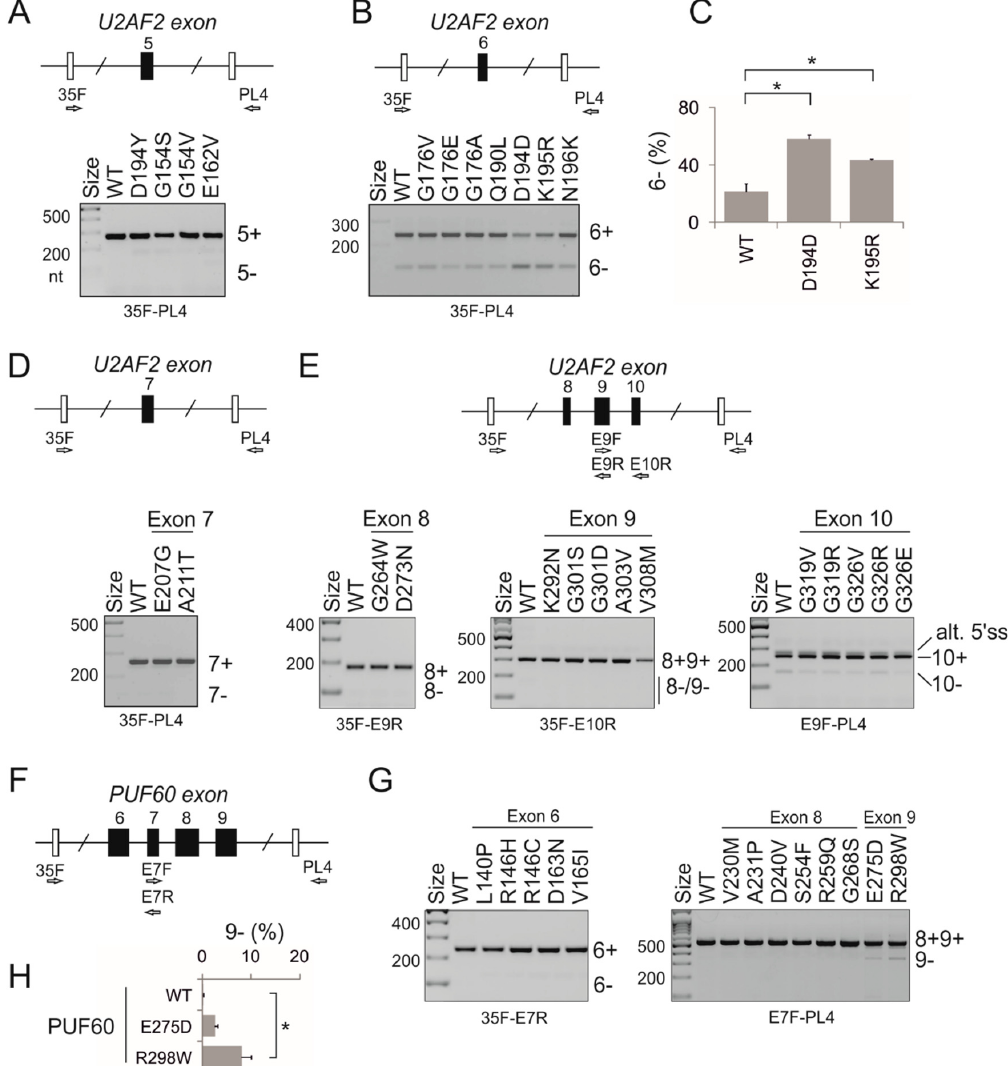
Figure 5. Identification of cancer-associated U2AF2 and PUF60 missense mutations that alter exon inclusion in cis . ( A – E ) U2AF2 , ( F – H ) PUF60 . Minigene constructs are schematically depicted above exon-specific panels. Tested exons are denoted by black rectangles and numbered. Terminal minigene exons are shown as open rectangles. RT-PCR primers (Table S2) are denoted by arrows and cloning sites by a slash. RNA products are shown to the right; +, exon inclusion; − , exon exclusion in the mRNA. Exon inclusion levels are in panels C ( U2AF2 ) and H ( PUF60 ). Error bars are SDs (n-method) of two transfection experiments. Asterisks denote significant differences between the WT and mutants ( p < 0.05; one-way analysis variance with Dunnett’s multiple comparison post-hoc tests). Alt. 5 ′ ss (panel E) is an alternative GC 5 ′ ss of U2AF2 exon 10, which is used by endogenous HEK293 transcripts at <25% [24] .